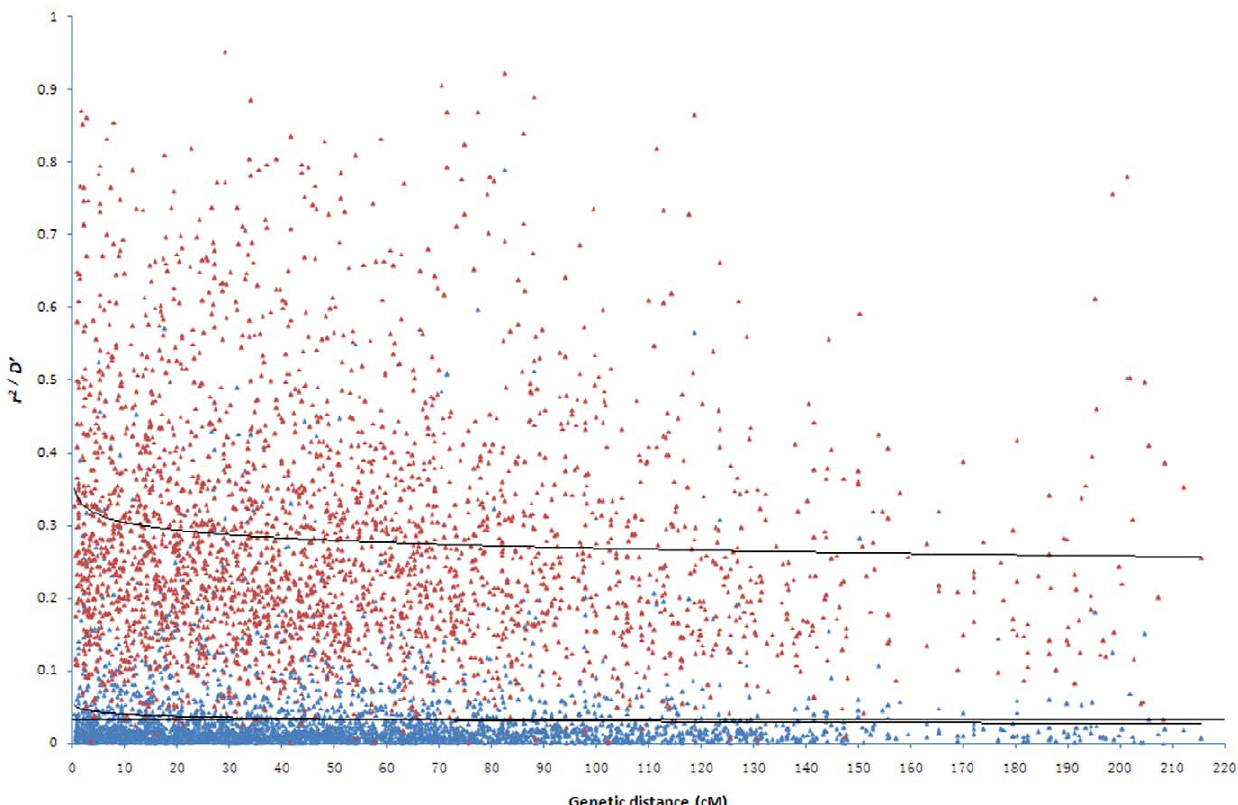
Figure 7. LD decay plot within the entire population. Squared correlations of allele frequencies ( r 2 , blue triangles) and weighted standardized disequilibrium coefficient ( D ’, red triangles) against genetic distance(cM) between linked loci in the entire population. The horizontal line indicates the 75th percentile of r 2 for unlinked loci. doi:10.1371/journal.pone.0027565.g007 PLoS ONE |